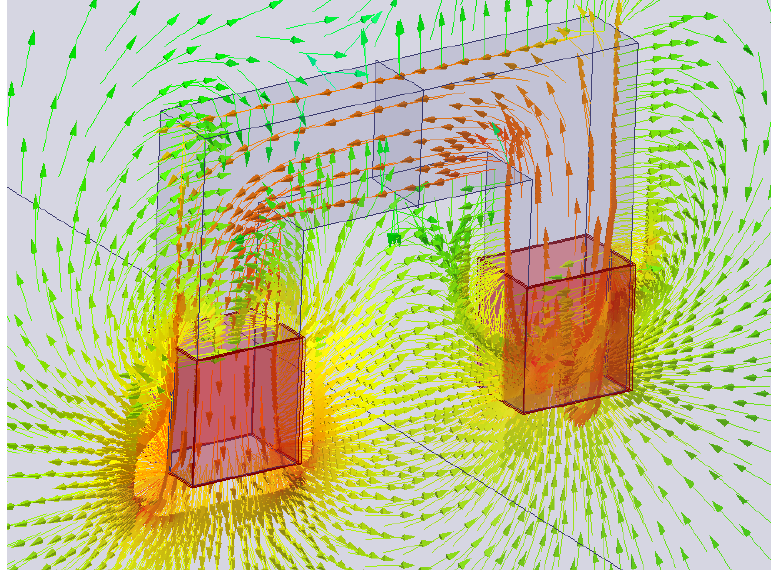
Figure 4. Two winding probe: flux density predicted by FEM